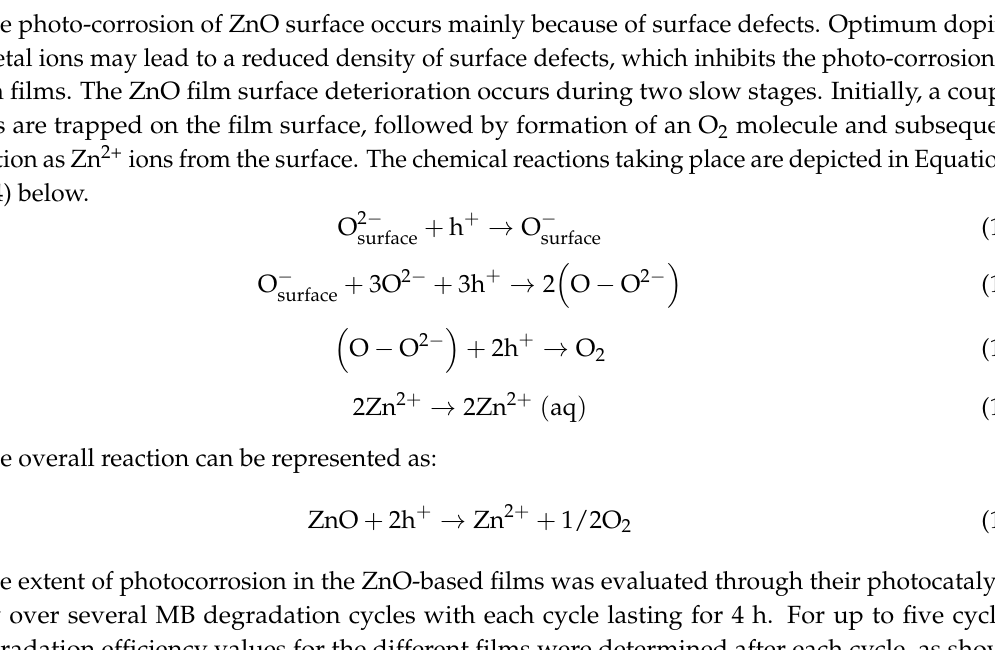
Figure 8. Pseudo-first-order plots representing ln( C / C 0 ) versus illumination time for calculation of apparent reaction rate constant for MB degradation in the case of: ( a ) ZnO:Ag films and ( b ) ZnO:Al films.